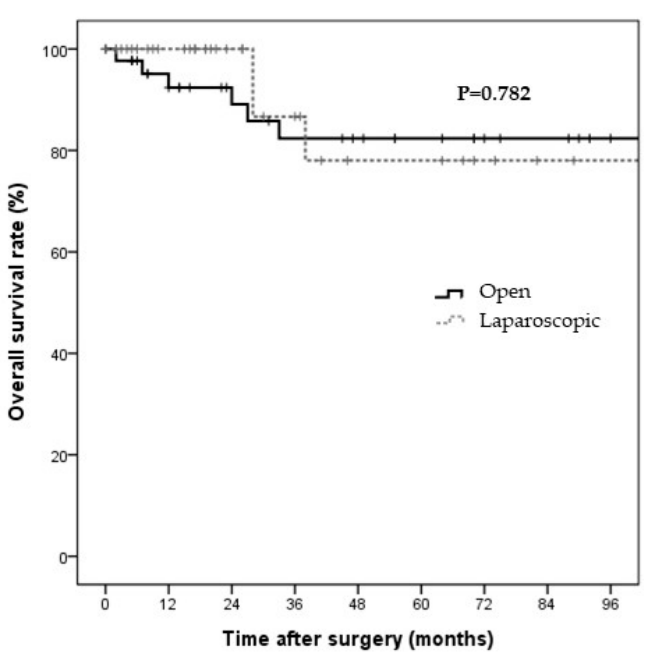
Nineteen patients in each group were selected for PS-matching analyses. All covariates were well-balanced between the two groups (C-statistic = 0.808). The surgery types